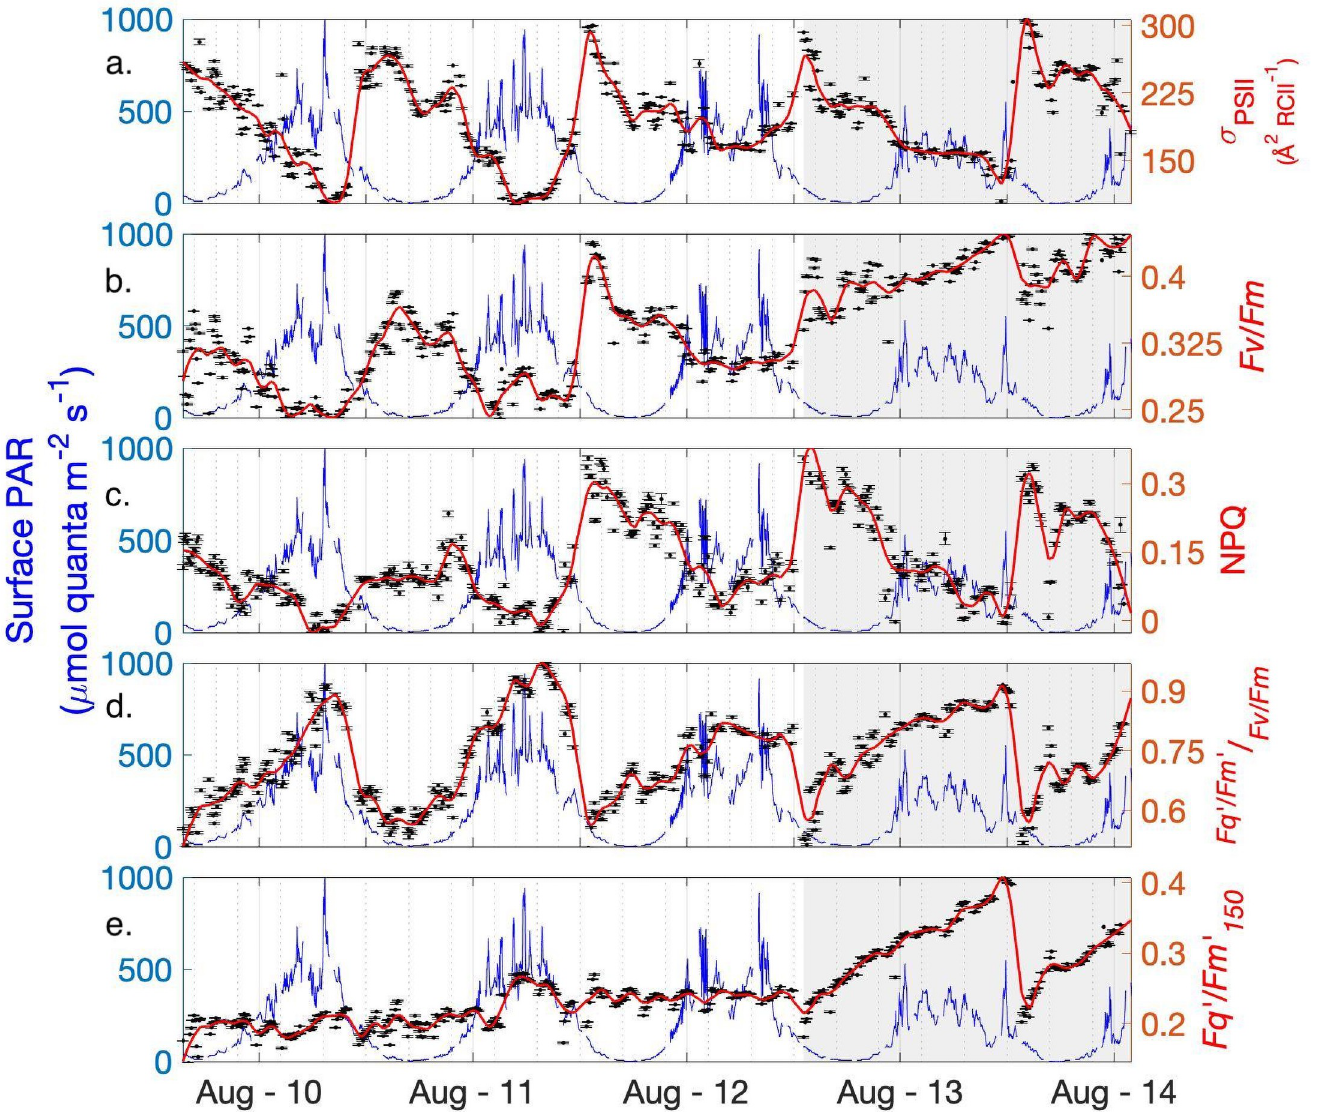
Fig 3. Summary of photophysiological conditions. Semi-continuous FRRf measurements of photophysiology (black dots) are superimposed over the in-situ surface PAR (blue line). A loess smoothing function was applied to photo-physiological measurements (red line). Shading denotes the Barrow Strait portion of the transect.